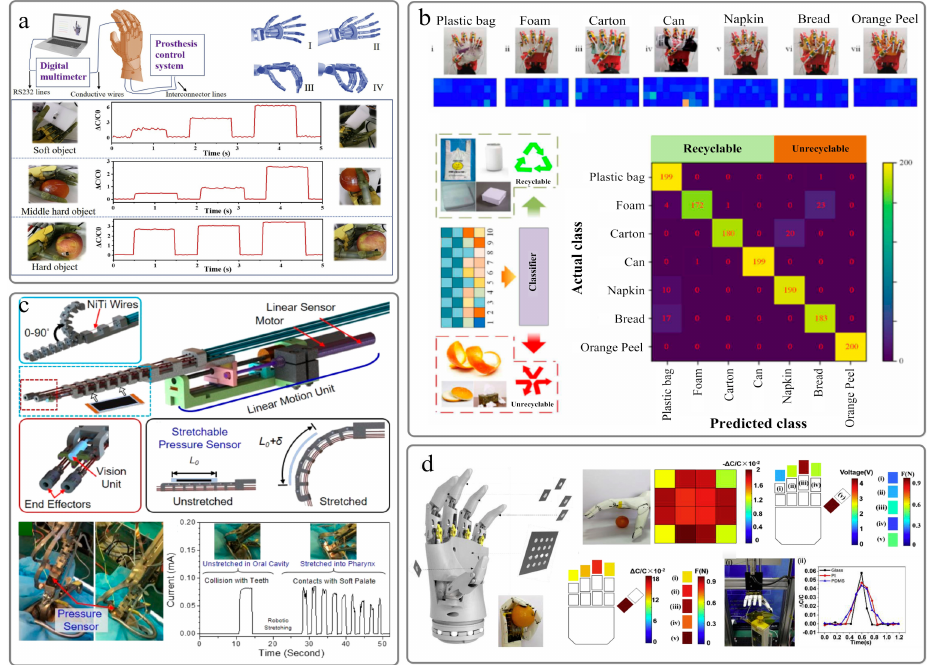
Figure 7. Flexible pressure sensor for smart robot. ( a ) Object recognition. Reprinted with